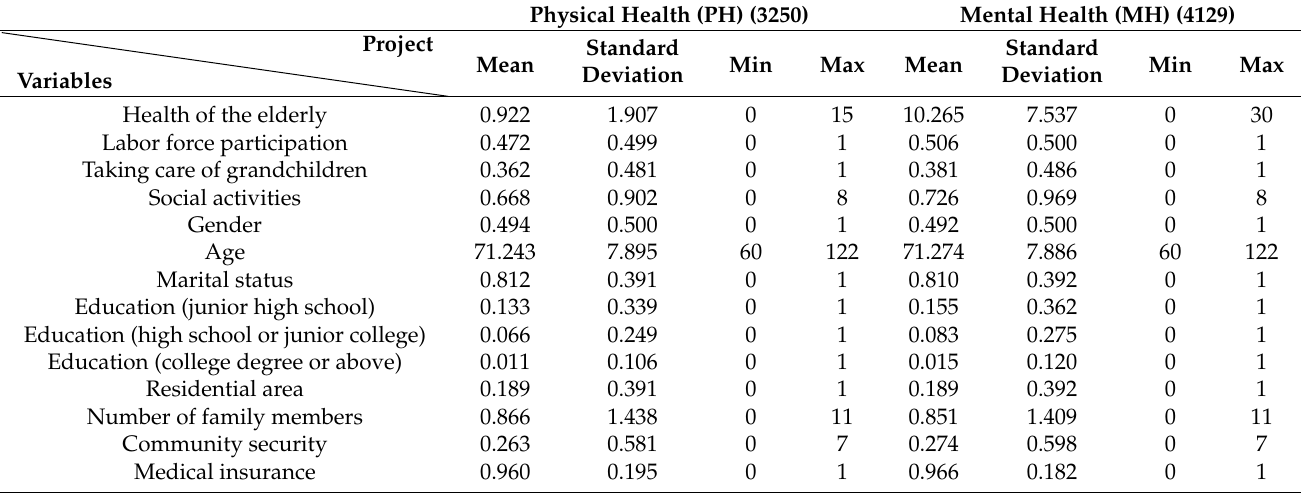
Table 1. Variables and data